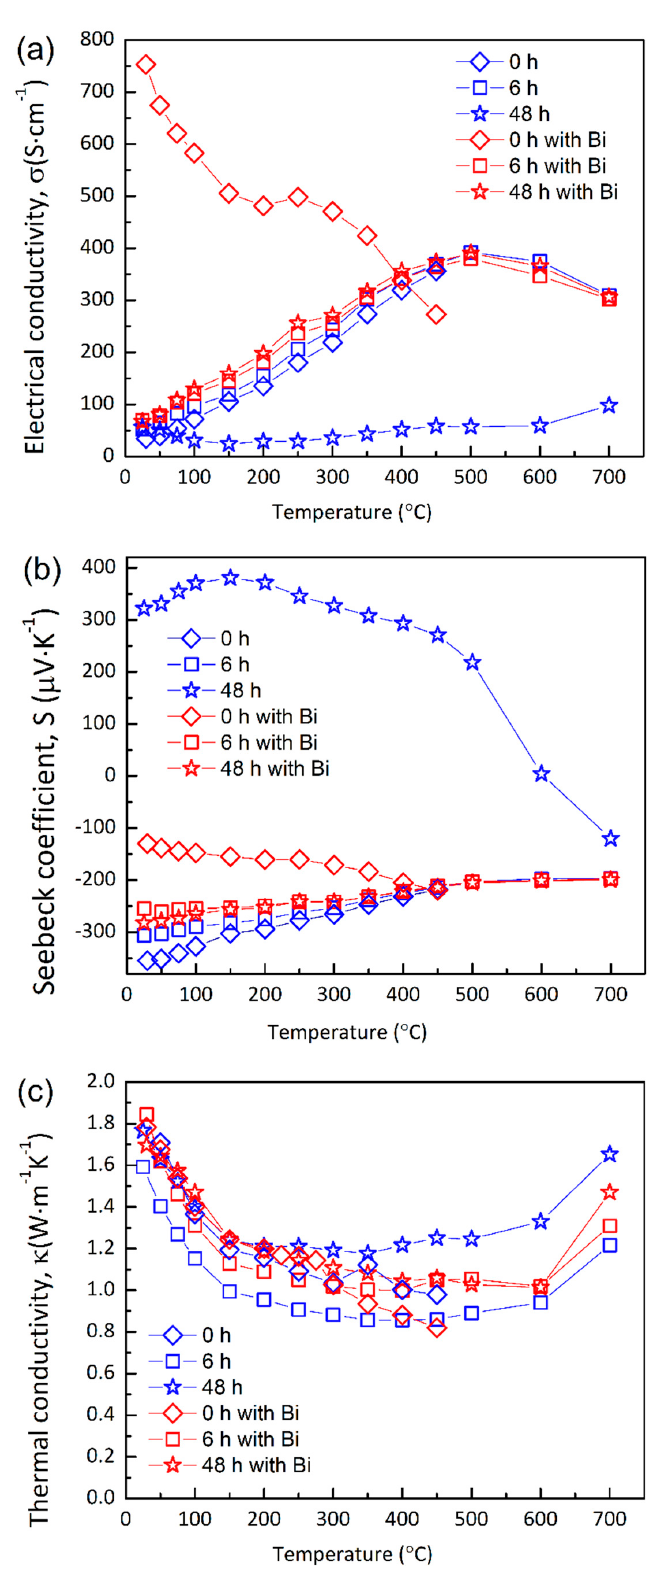
Figure 4. The temperature dependent ( a ) electrical conductivity, ( b ) Seebeck coefficient, and ( c ) thermal conductivity values measured for the hot-pressed (HP) series of specimens aged at 380 °C for 0 (diamonds), 6 (squares), and 48 h (stars) for the Bi-free (blue symbols) and Bi-alloyed (red symbols) materials.